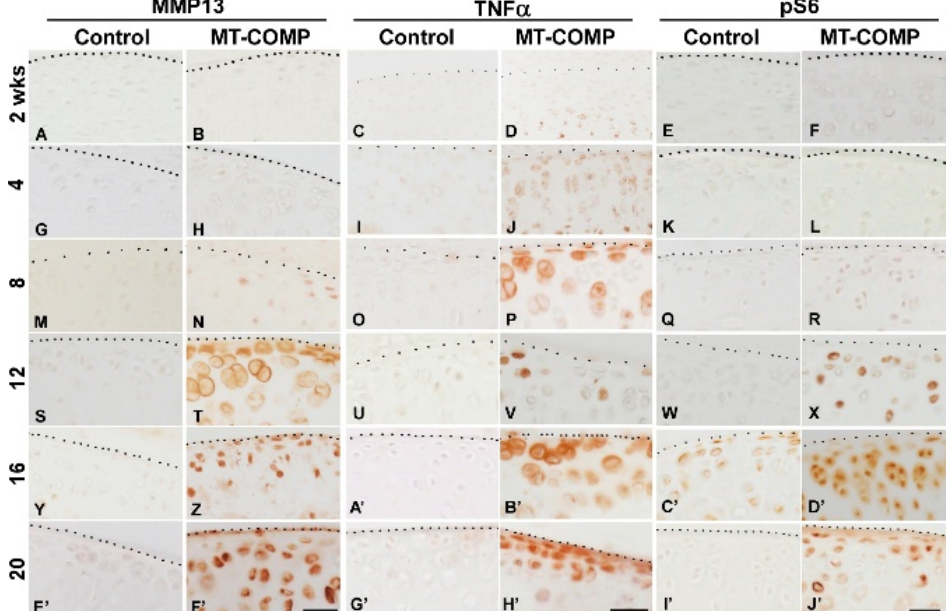
Figure 2. Degradation, inflammation, and autophagy blockage is increased in MT-COMP articular cartilage/chondrocytes. All mice were administered DOX from birth to collection at 2, 4, 8, 12, 16, and 20 weeks. Dotted line marks the edge of articular cartilage. Control and MT-COMP tibial articular cartilage were immunostained (brown) using MMP13 (brown A , B , G , H , M , N , S , T , Y , Z , E’ , F’ ),TNF α (brown C , D , I , J , O , P , U , V , A’ , B’ , G’ , H’ ), or pS6 (brown E , F , K , L , Q , R , W , X , C’ , D’ , I’ , J’ ). Control mice show no MMP-13 or TNF α signal and minimal pS6. In contrast, the MT-COMP articular chondrocytes show minimal MMP-13 at 8 weeks, which is increased by 12 weeks; TNF α expression is found in the deep zone of the articular cartilage at 2 weeks of age and in all three layers at 4, 8, 12, 16, and 20 weeks; pS6 signaling is seen at 12, 16, and 20 weeks. Bar = 100 µ m. Autophagy is repressed in both OA articular chondrocytes [52] and MT-COMP growth plate chondrocytes [42], therefore, MT-COMP articular chondrocytes were assessed